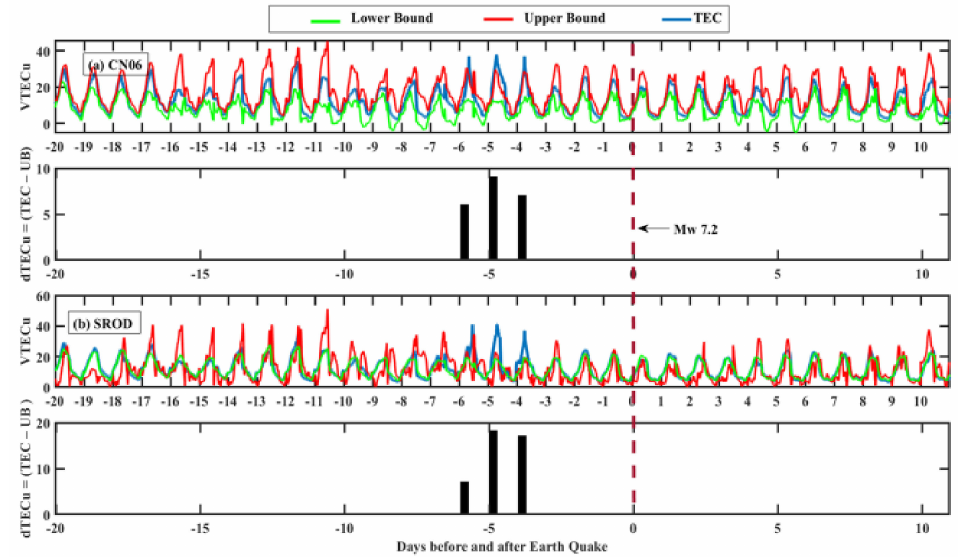
Figure 4. Deviation in VTEC beyond the upper bound on the day ( − 6, − 5, − 4) for ( a ) CN06 and ( b ) SROD stations before the main shock of M w 7.2 EQ. The red dashed line represents the EQ day. The anomaly on day − 5 is clear over the epicenter from GNSS